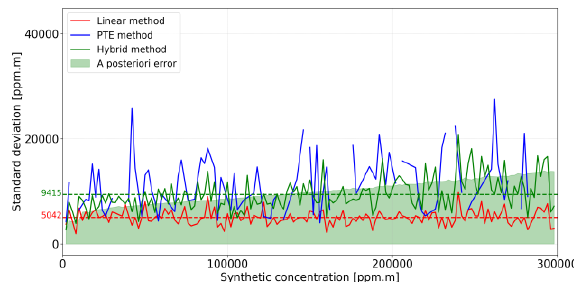
Figure 8 . Standard deviations according to the synthetic plume concentration for the water case. The a posteriori uncertainty is plotted for the same concentrations.